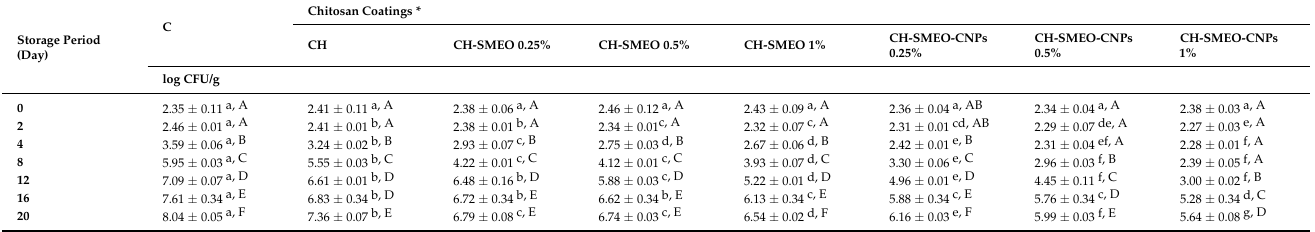
Table 3. Effect of the addition of chitosan coatings and chitosan-based nanoparticles enriched with Satureja montana L. essential oil on the change in the total viable counts (TVC) in beef samples during